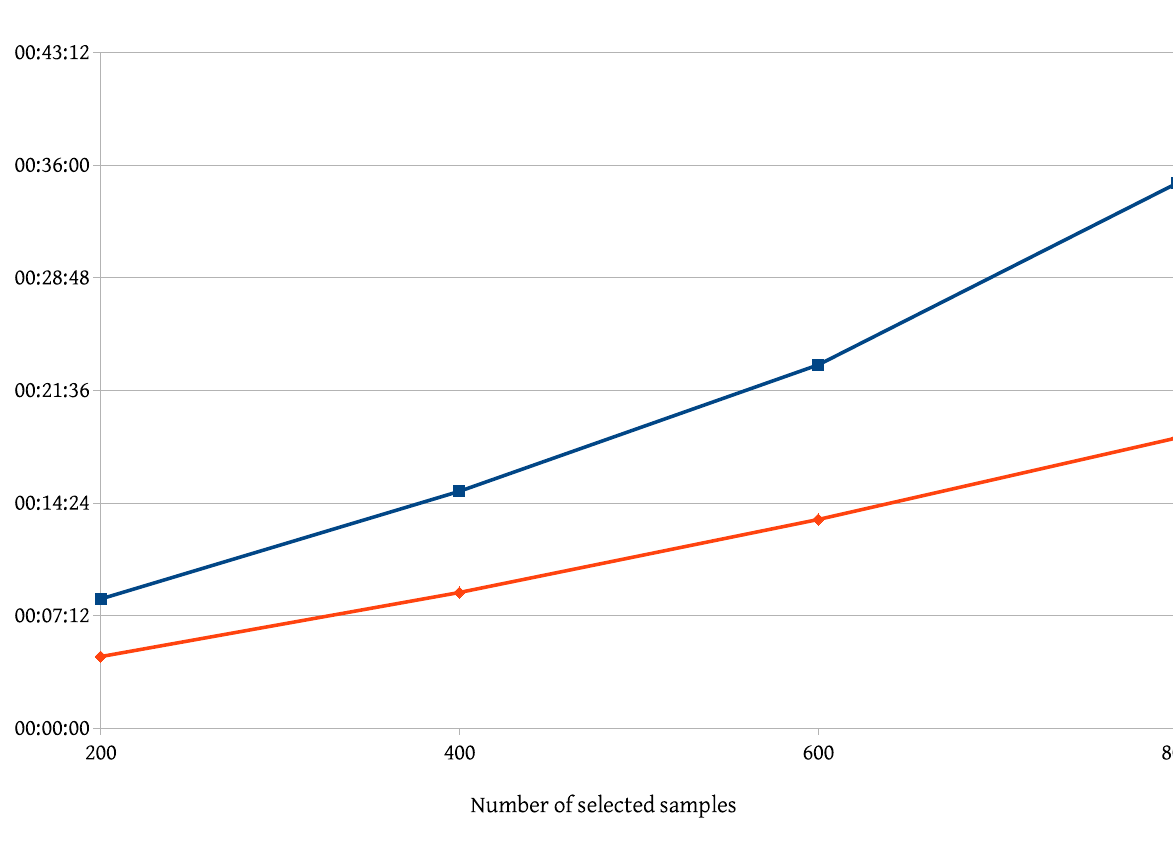
Figure 7. Comparison of traditional methods of sample selection and our method in terms of time